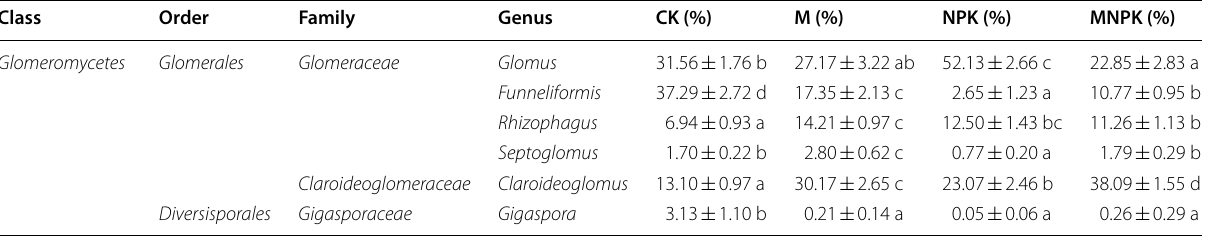
Values within the same row followed by different letters indicate significant differences ( P < 0.05) according to Tukey’s multiple comparison At least one group’s relative abundance is more than 1% of the total sequences Treatment: CK, no fertilizer; M, manure; NPK, chemical nitrogen, phosphorus and potassium fertilizer; MNPK, chemical nitrogen, phosphorus and potassium fertilizer plus manure